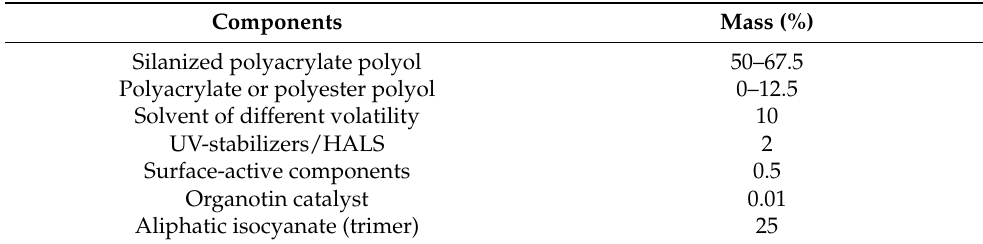
Table 2. Typical silanized PUR formulations used in this